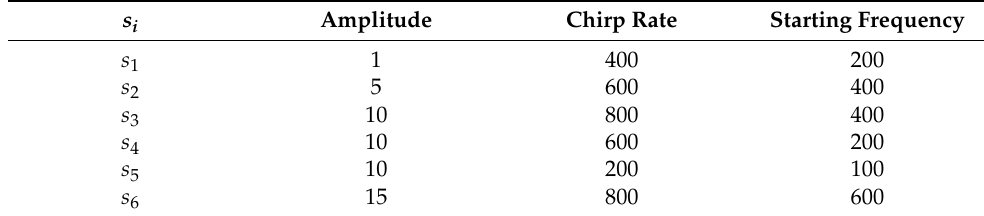
Table 2. Six chirp signals with different